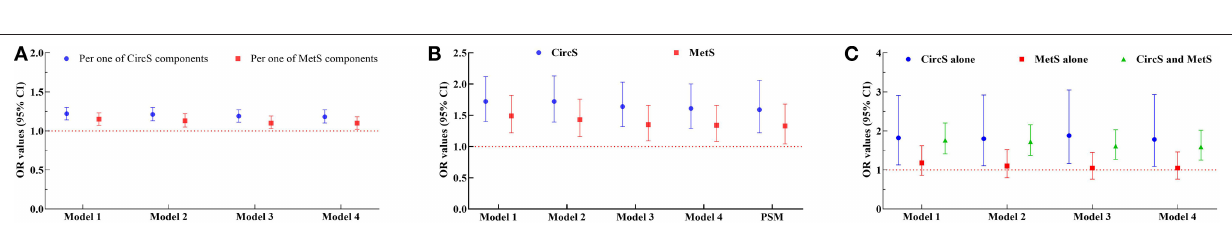
FIGURE 3 | The cross-sectional association between metabolic syndrome (MetS), circadian syndrome (CircS), and prevalent LUTS/BPH. (A) Odds ratios (ORs) of the CircS and MetS groups varied with the numbers of their components; (B) ORs of CircS and MetS groups; (C) ORs of the CircS alone, MetS alone, and both CircS and MetS groups. ORs were calculated using logistic regression. Model 1 was performed using univariate logistic regression. Model 2 was adjusted for age, education, marital status, and uric acid in blood. Model 3 was further adjusted for smoking and alcohol consumption. Model 4 was then further adjusted for anemia, stroke, and CKD. Propensity scores matching (PSM) was performed using MatchIt package in R 3.6.3. MetS, metabolic syndrome; CircS, circadian syndrome; PSM, propensity scores matching; OR, odds ratios; CI, confidence